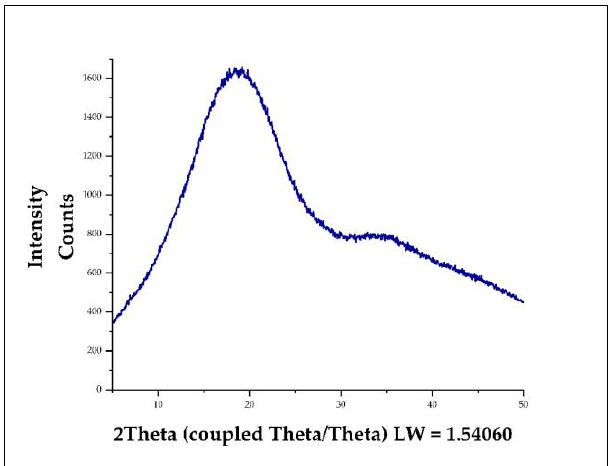
Figure 9. X-ray diffraction pattern of all nanoencapsulates.